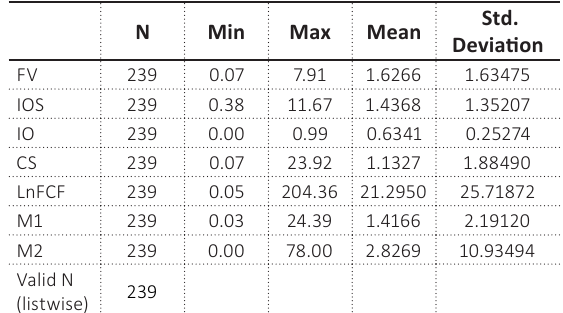
Table 2. Descriptive statistics